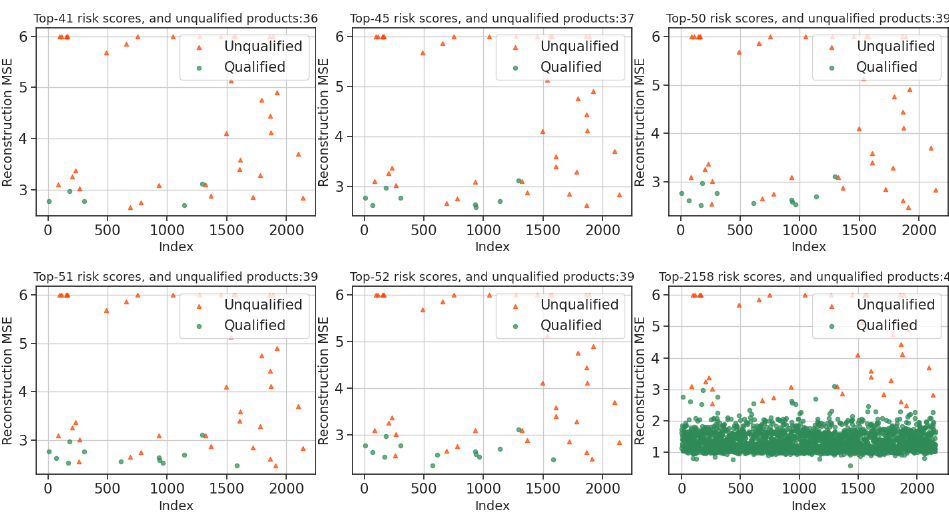
Figure 8. Top-n risk score visualization. n indicates the ranking order of risk scores. Index number means the sample